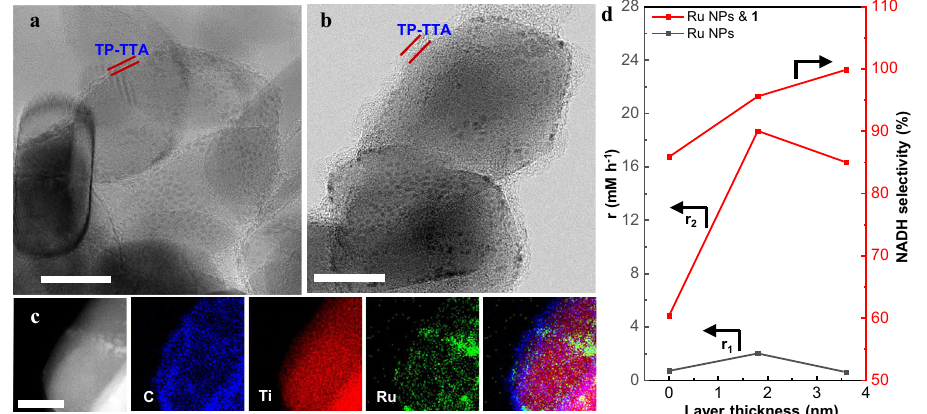
Fig. 4 | Characterizations and hydrogenation performance of Ru/TiO 2 @TP- TTA. TEM images of a Ru/TiO 2 @5TP-TTA, b Ru/TiO 2 @10TP-TTA, c STEM image of Ru/TiO 2 @10TP-TTA and the corresponding EDX mapping and the